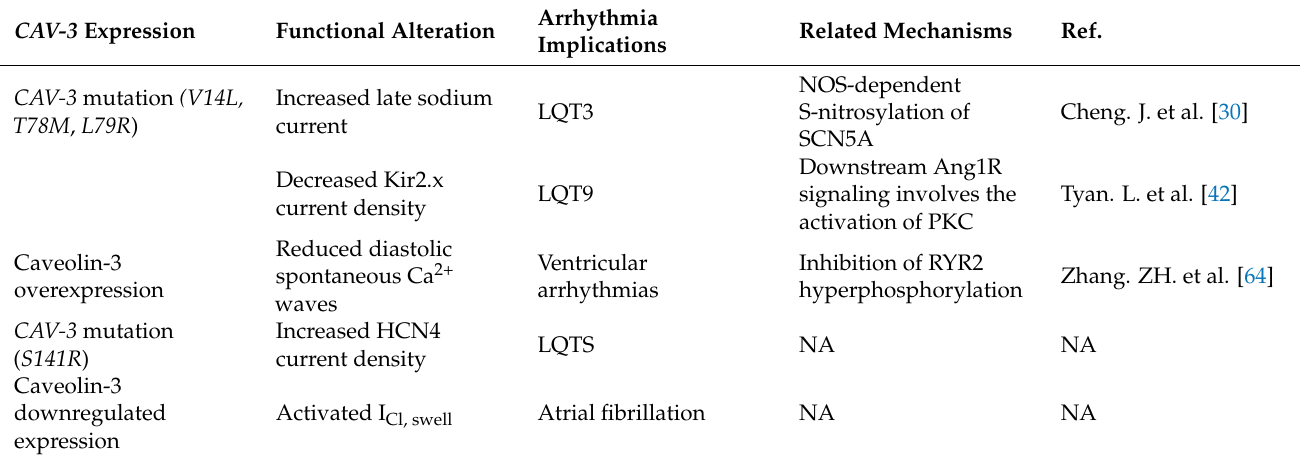
Table 2. The arrhythmia mechanism associated with change of CAV-3